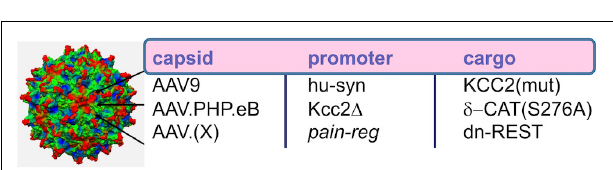
FIGURE 5 | AAV-based gene therapeutic avenues toward enhancement of Kcc2 gene expression. Re capsid type, AAV9 worked well in Yeo et al., where intrathecal injection led to viral transduction of central neurons in the spinal cord. AAV.PHP.eB might have increased tropism for central neurons over peripheral neurons, and AAV.(X) refers to future capsid variants that will ideally target pain relay neurons selectively. Re promoter, the short human synapsin promoter, was used successfully in Yeo et al. Kcc2 (cid:49) refers to an engineered Kcc2 promoter that has been cleared of repressor sites, such as those lacking both RE-1 elements and lacking the upstream Kaiso site; this promoter will have to be tested in future studies. Re cargo, this refers to transgene. This could be KCC2 itself. In that case, point mutations that enhance KCC2 chloride extrusion will be advantageous. For indirect enhancement of gene expression which might be more suitable for long-term effective treatments, delta-catenin that cannot be phosphorylated or dominant-negative REST are suitable